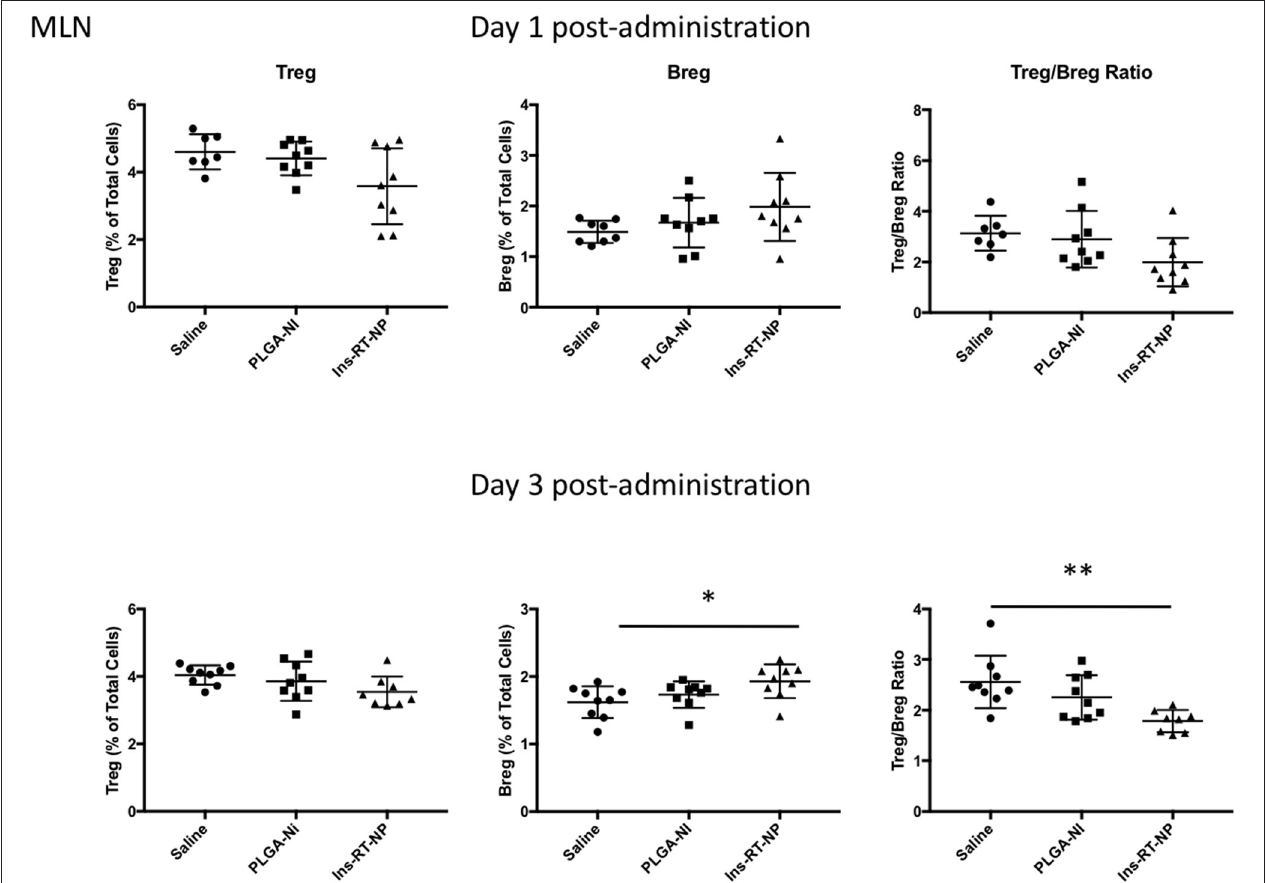
FIGURE 6 | Changes in the frequency of regulatory lymphocyte cell populations inside the MLN of NOD mice following acute microparticle administration. Animals from the acute study cohort (See timeline in Figure 4A ) were euthanized at 1 or 3 days following test article administration. Single cell suspensions from resected MLN were then assessed by flow cytometry for Treg and Breg frequency. A non-significant downward trend is seen in Treg frequency in MLN of mice treated with Ins-RT-NP vs. saline. Breg frequency exhibited an upward trend in mice treated with Ins-RT-NP, becoming statistically-significant significant compared to control test articles by the time of the third injection ( n = 9, ANOVA p = 0.0262). Tukey’s multiple comparisons determined p = 0.0215 between the saline and Ins-RT-NP treatment group. The Treg/Breg ratio was similarly significantly-different with the three-injection treatment (ANOVA p = 0.0035, post test p = 0.0025 for saline vs. Ins-RT-NP). Statistical significance is displayed as * for p < 0.05 and ** for p < 0.01 as assessed by ANOVA. Data are combined from the outcomes in two independent animal cohorts examined at different times in the